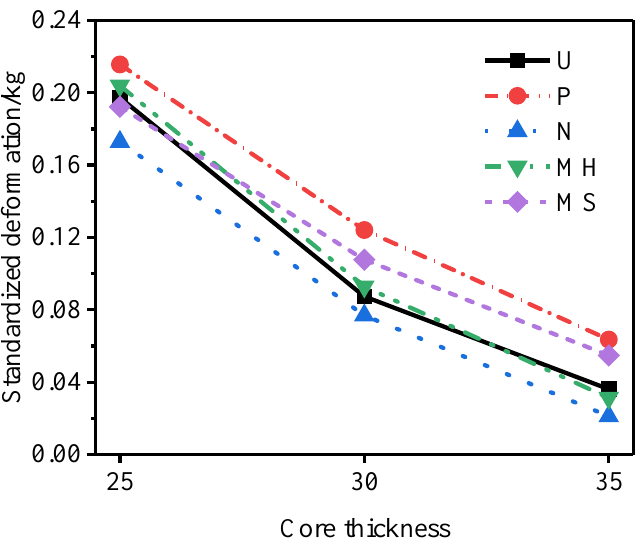
Figure 23. Deformation of the outer tubes of sandwich tubes with different core thicknesses.